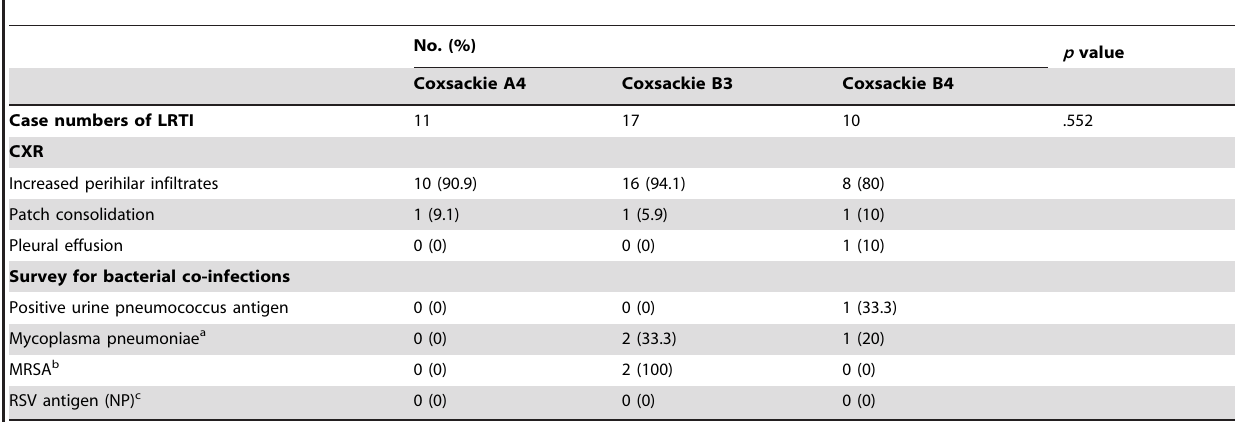
Table 5. Chest X ray findings and results of etiology survey in hospitalized lower respiratory tract infection (LRTI)